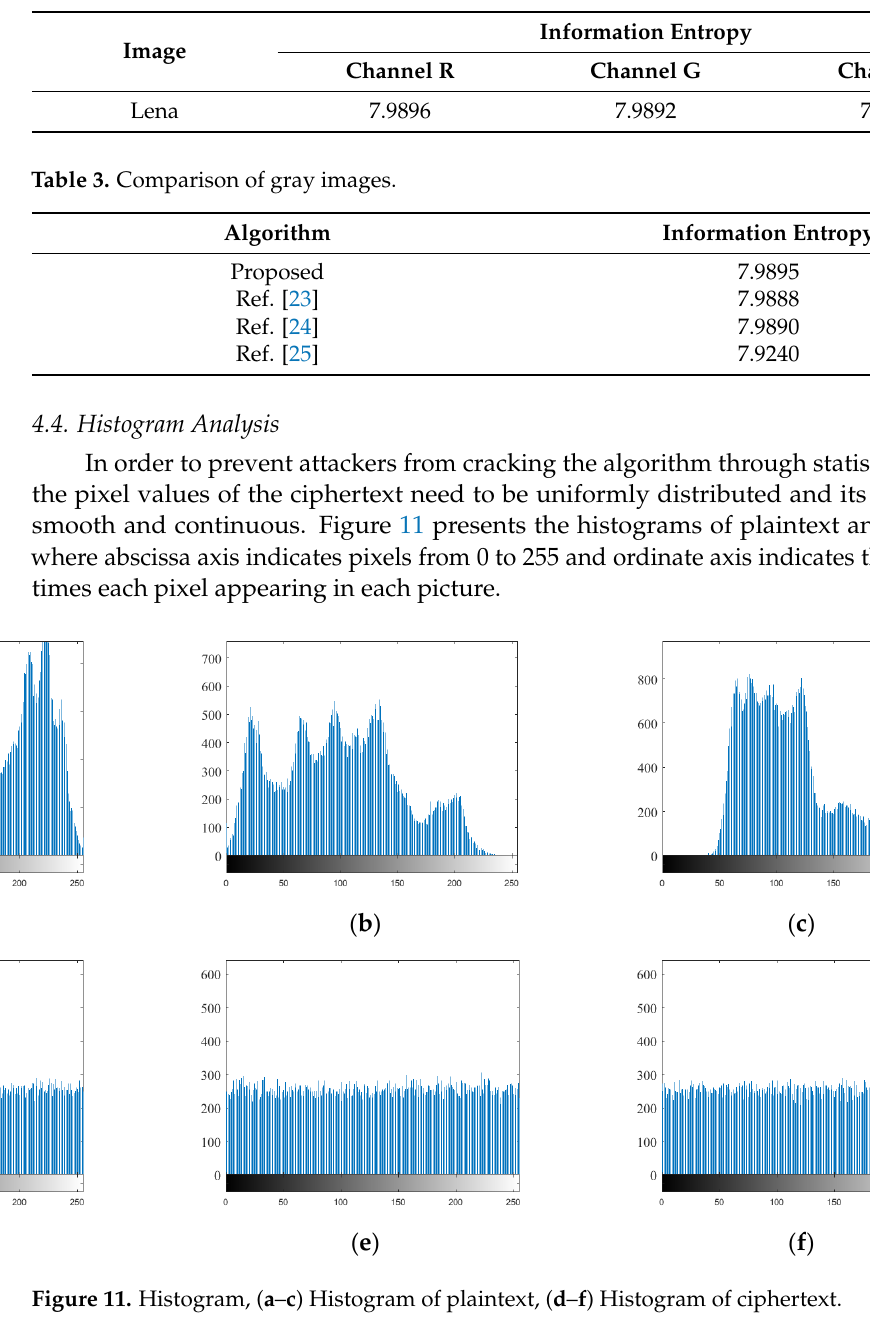
Table 2. Information entropy test.